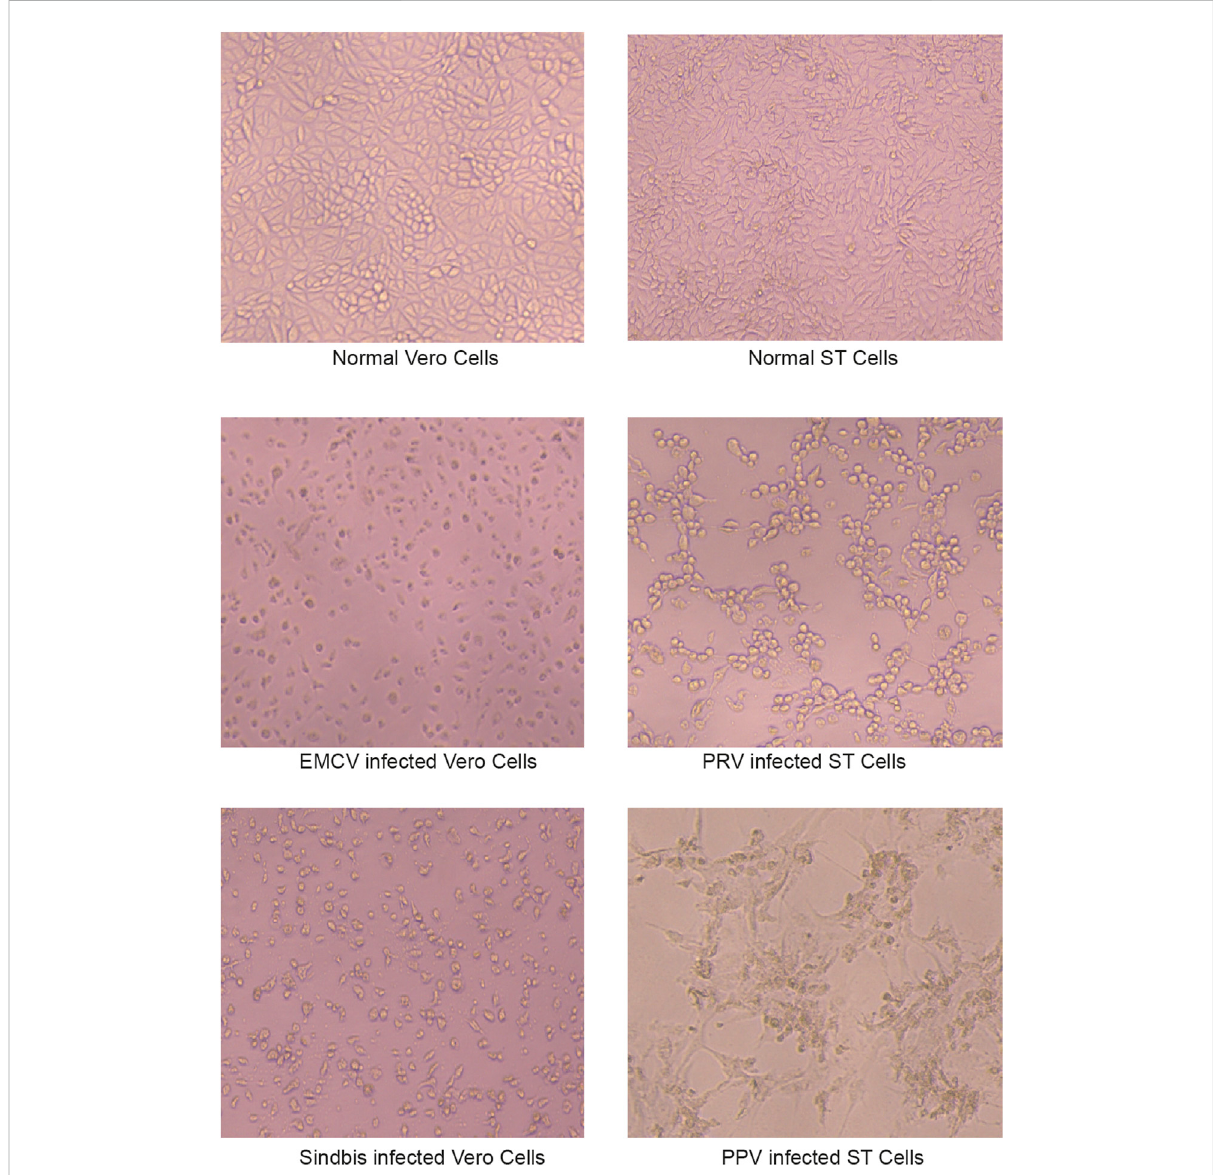
FIGURE 3 The indicating cells for virus concentration determination. ST cells were used as the indicating cells to calculate the reduction of PRV and PPV titer. Vero cells were used for Sindbis and EMCV